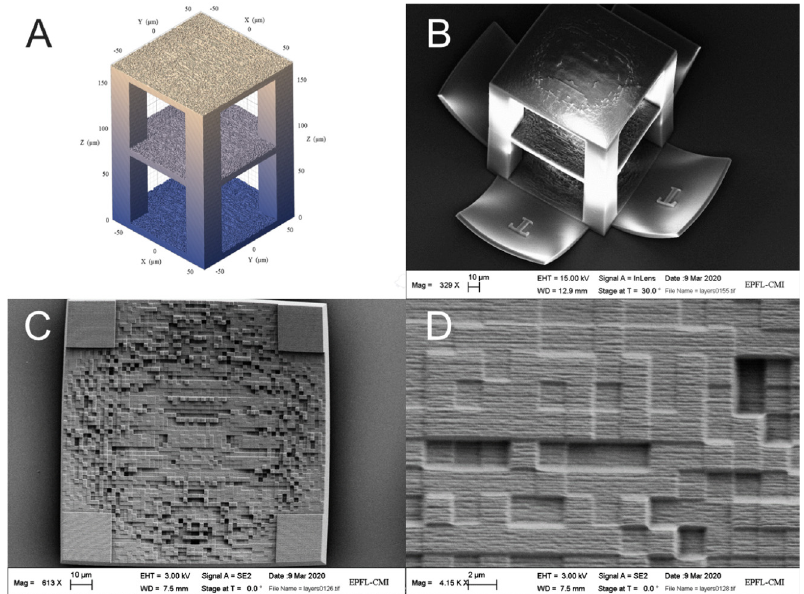
Figure 9: (A) CAD renderingof 3-layer volume element. (B) Scanning Electron Microscope image of the volume element with four additional bases on sides. (C) One layer of the Volume element. (D) Zoomed in